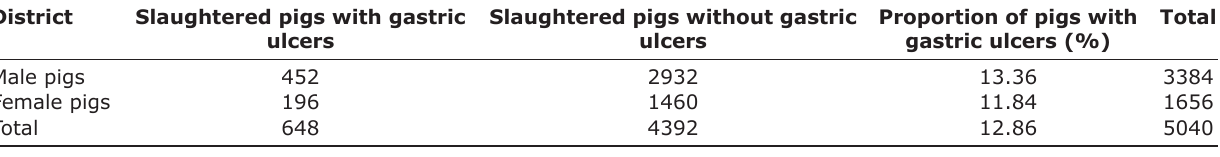
Table-3: Overall occurrence of gastric ulcers in slaughtered pigs according to sex.